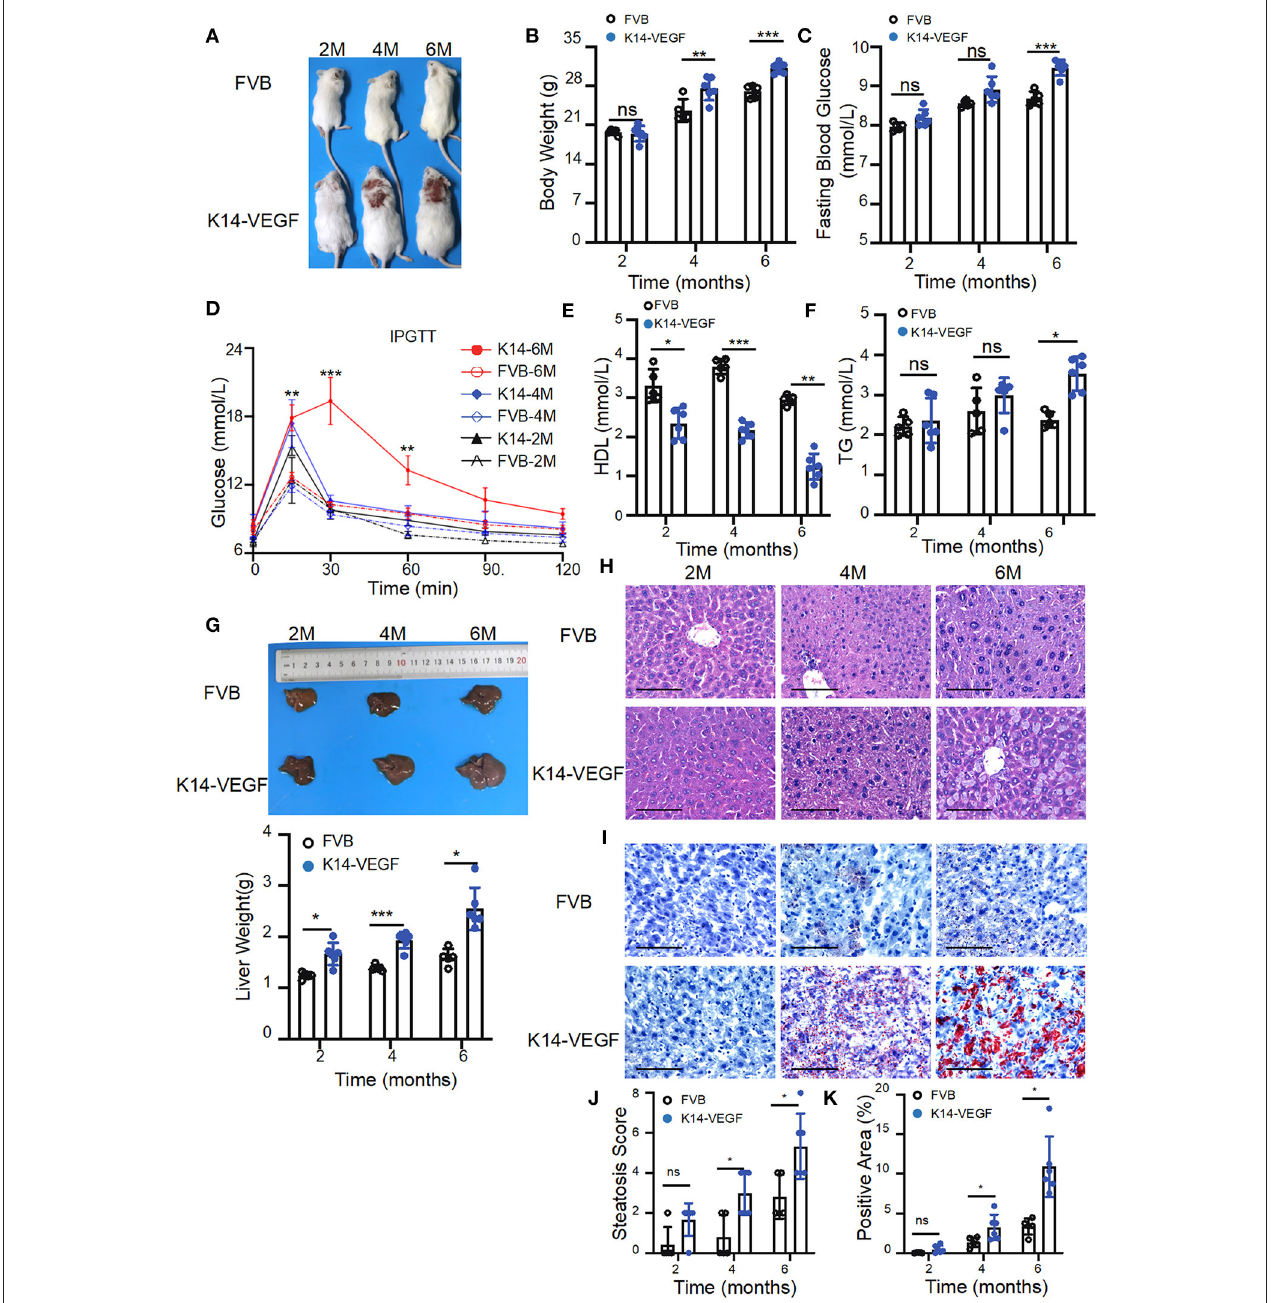
FIGURE 1 | Aged K14-VEGF-A-transgenic mice, which exhibited psoriasis-associated phenotypes were more likely to have metabolic disorders compared to FVB. (A) Representative images of each group. FVB ( n = 5) and 2-, 4-, and 6-month-old K14-VEGF - A-transgenic mice ( n = 6). (B) Body weight of mice. (C) Fasting serum glucose levels. (D) Blood glucose concentrations following intraperitoneal glucose tolerance tests. (E) TG levels. (F) HDL levels. (G) Representative pictures and weight of livers. (H) Representative H&E-stained sections of liver. Scale bar, 100 µ m. (J) Degrees of hepatic steatosis. (I) Oil red Staining of livers. Scale bar, 100 µ m. (K) Quantification of hepatic ORO. Statistical analysis for (B – K) : Each symbol represents a mouse; bars show means and SEM. Statistical tests used were two-way ANOVA in all data. * P < 0.05, ** P < 0.01, and *** P <